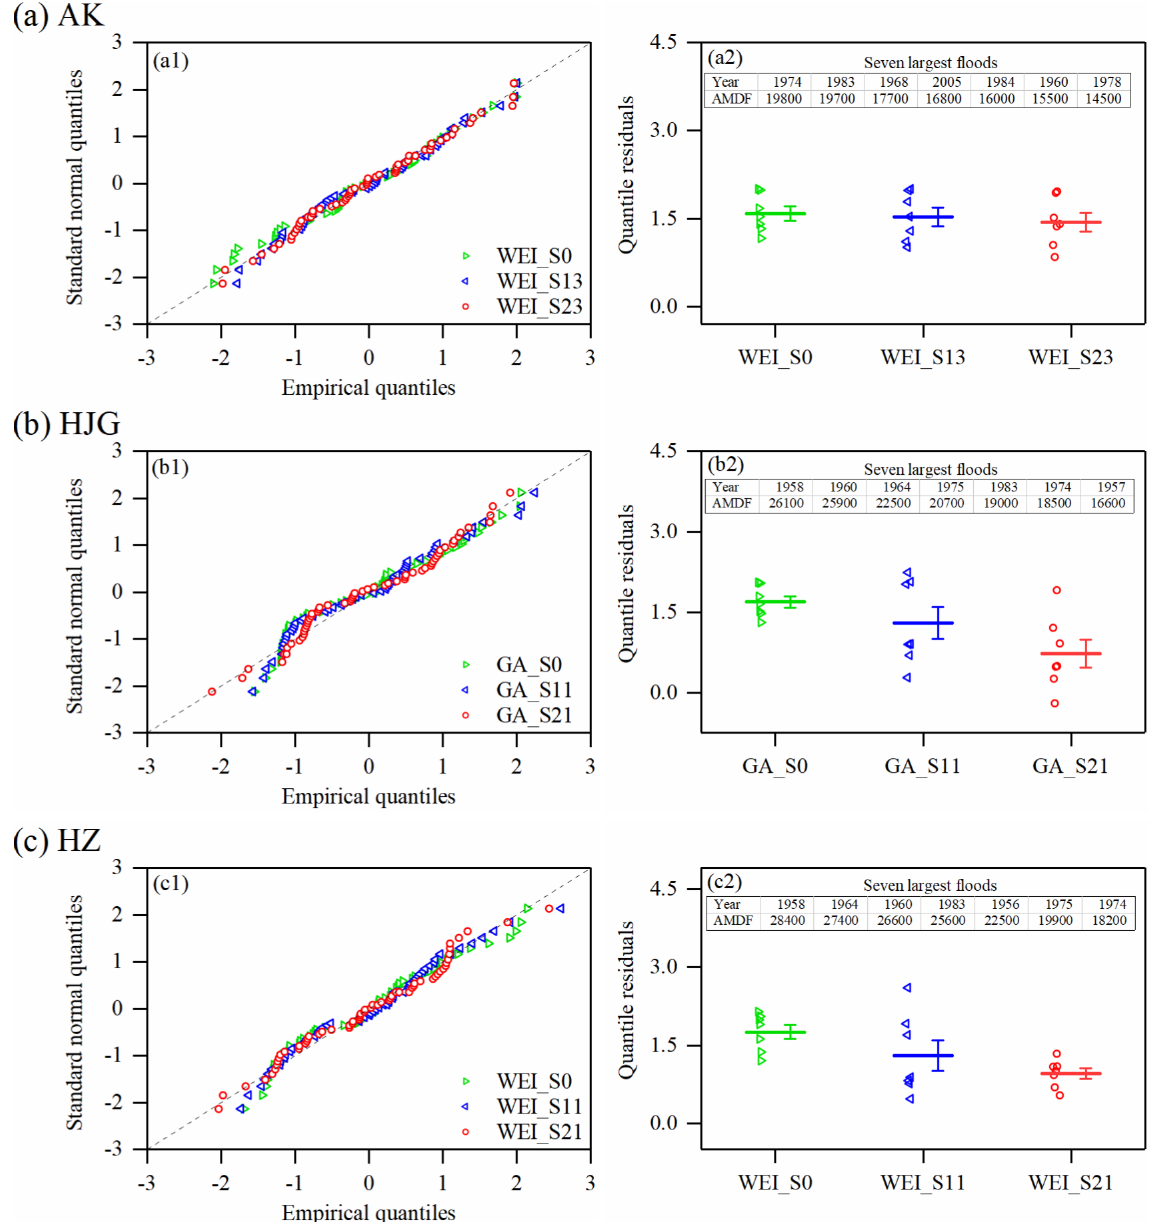
Figure 7. Comparison of the stationary (S0), the RI-dependent (S1), and the RRCI-dependent (S2) scenarios of the same optimal distributions for (a) the AK station, (b) the HJG station, and (c) the HZ station. The left panels (a1, b1, c1) are the Q–Q plots for the entire AMDF series in each station. The right panels (a2, b2, c2) are the plots of the quantile residuals for the seven largest floods (their values and occurrence years have been listed) in each station, and the means of their quantile residuals (points) and the corresponding standard errors are indicated by the